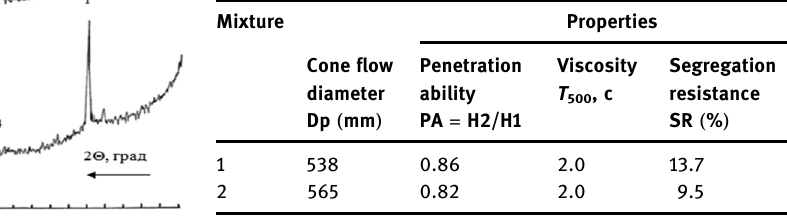
Table 13: Properties of nano - modi fi ed concrete